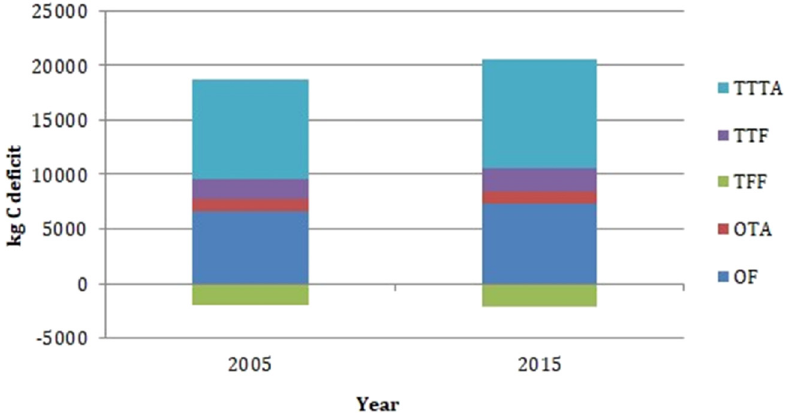
Figure 2: Evolution of land use impact of 1 m 3 of maritime pine, standing, in forest between 2005 and 2015. Acronyms: TTTA – transformation, to tra ffi c area, road embankment; TTF – transformation, to forest; TFF – transformation, from forest; OTA – occupation, tra ffi c area, road embankment; and OF – occupation, forest.